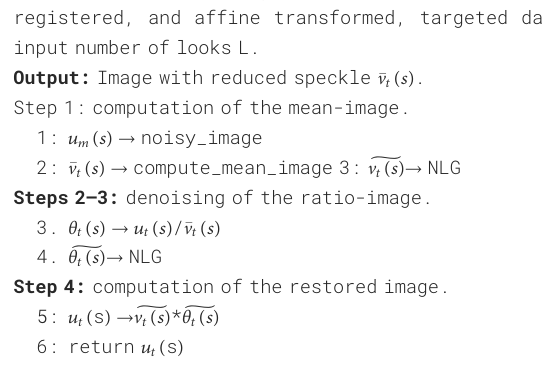
Figure 5 is the local magni fi cation of the ratio image obtained from Figure 4.